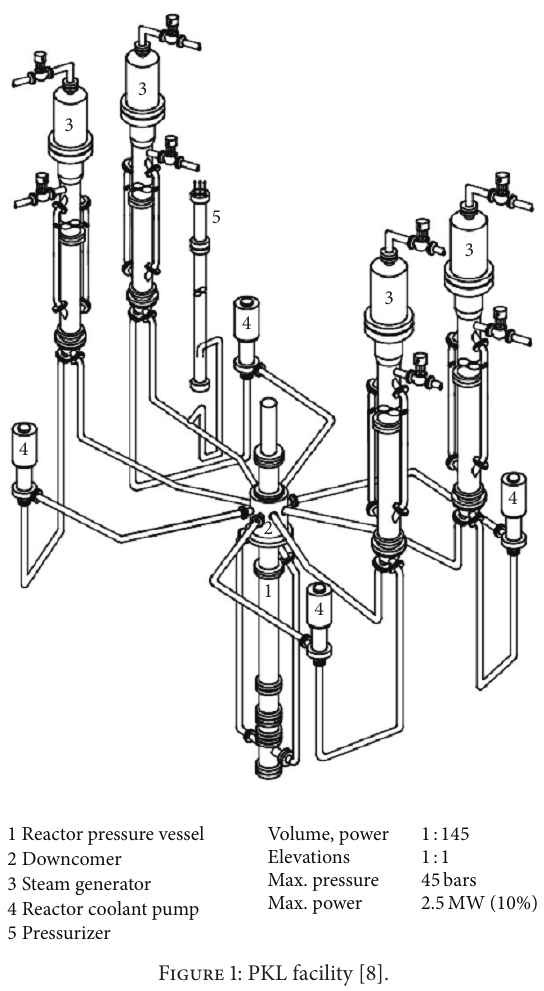
Figure 1: PKL facility